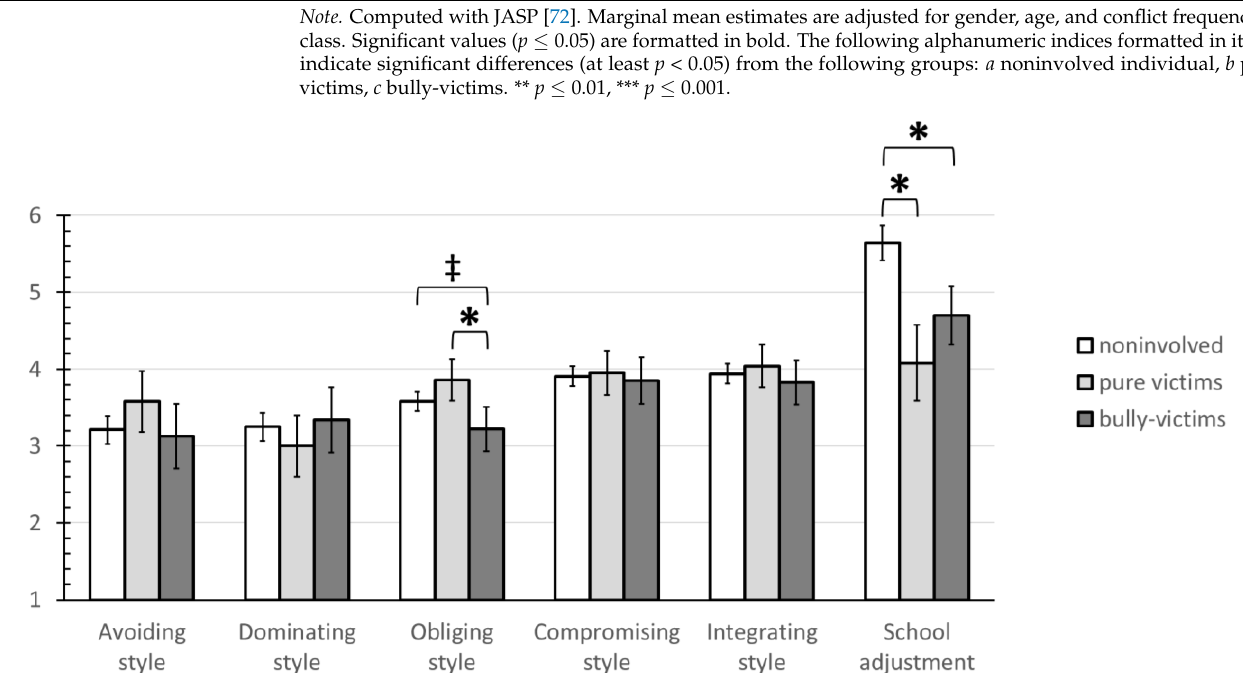
Figure 4. ANCOVA Results: Adjusted Means of Person-Oriented Bullying-Related Groups Regarding Conflict Management Styles and Psychological School Adjustment. Note. Marginal mean estimates are unstandardized scores adjusted for gender, age, and conflict frequency in class. Conflict management style is measured on a 5-point scale and psychological school adjustment on a 7-point scale. Whiskers represent 95% confidence intervals. Results of Tukey post-hoc tests: ‡ p ≤ 0.10, * p ≤ 0.05 (including lower significance